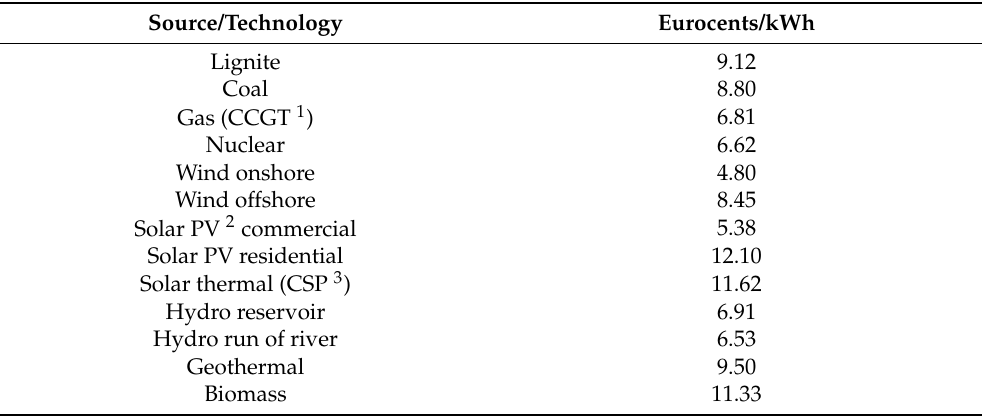
Table 3. Costs of different energy